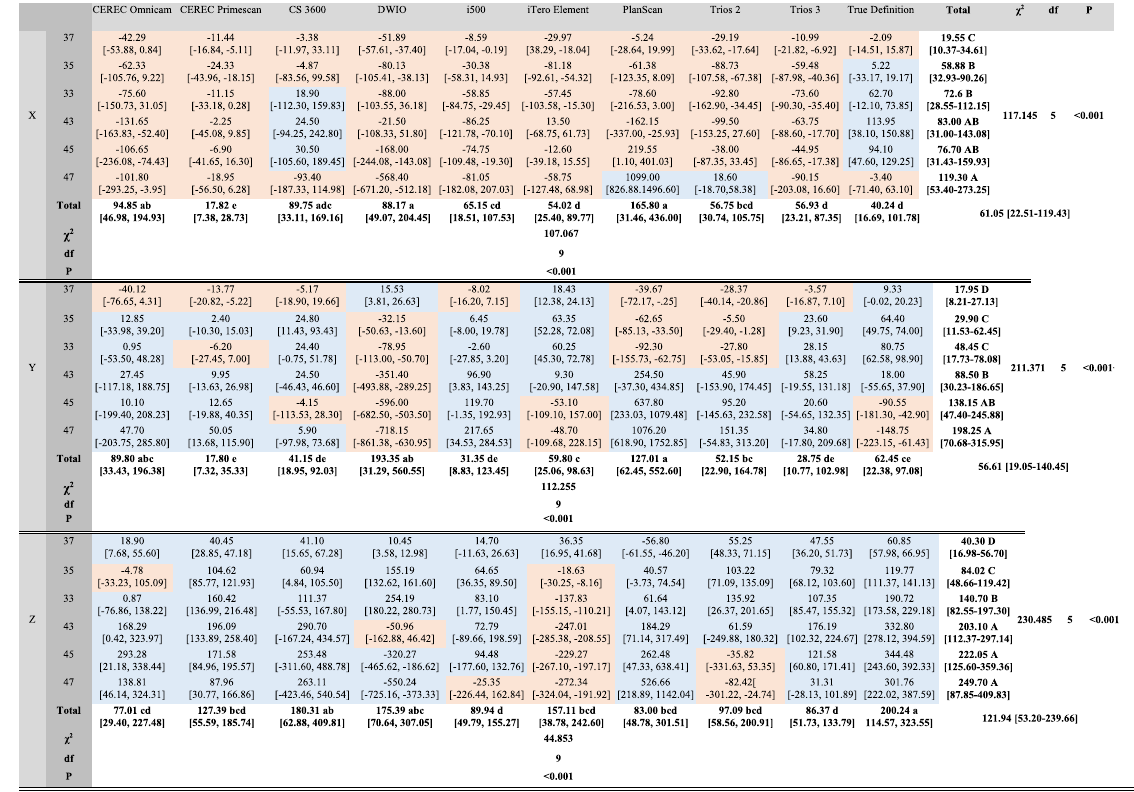
Table 2. Trueness values (μm) of IOSs at each cylinder position in XYZ axes. χ 2 , chi-square; df, degrees of freedom; p , p -value. Interquartile ranges [1st quartile, 3rd quartile] are in parentheses. Different uppercase letters within the same column indicate statistically significant differences among cylinder positions; different lowercase letters within the same row indicate statistically significant difference among IOSs (multiple comparison by Mann–Whitney U test with Bonferroni correction) ( p < 0.05). Positive (in blue shade) and negative values (in red shade) indicate deviation to the right and left in X-axis, forwards and backwards in Y-axis, upwards and downwards in Z-axis, respectively. Absolute values were used for statistical